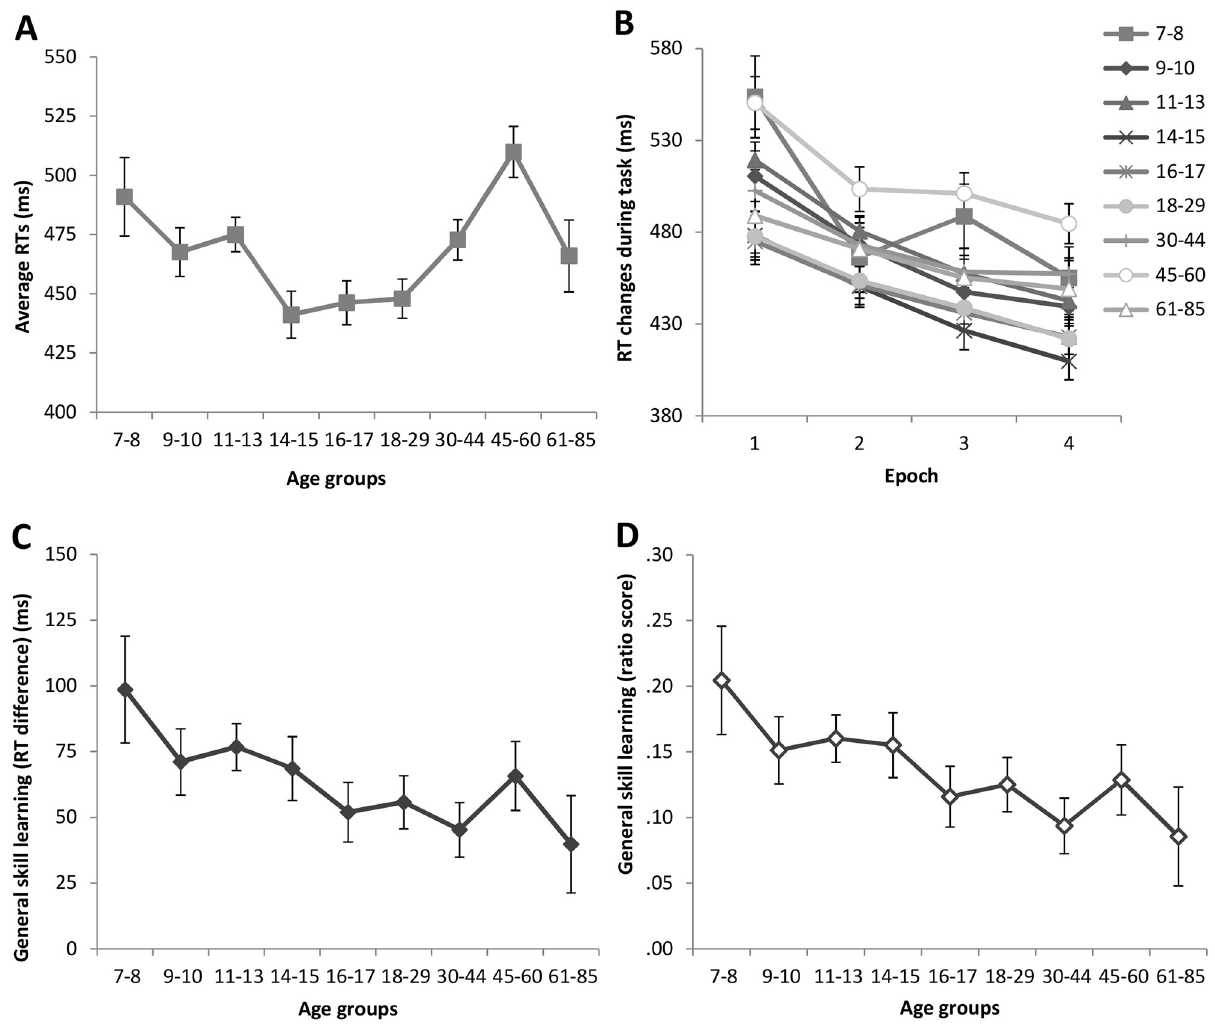
Fig 3. Average RTs (A) and general skill learning (B-D) across the lifespan for a subsample of the participants to control for age-related average RT differences. Only those participants are included in this subsample whose average RTs are between 400 and 550 ms. For details on the measures presented here see the legend of Fig 1. Error bars indicate standard error of mean